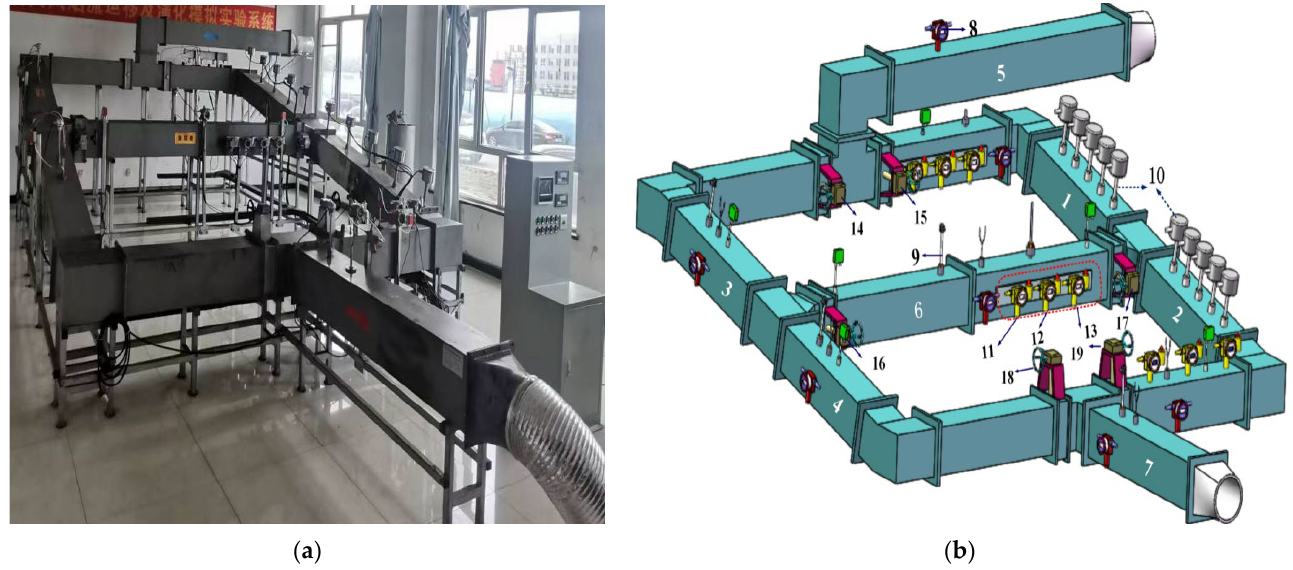
Figure 1. Experimental equipment: ( a ) Physical setup. ( b ) Schematic diagram. Note: 1. branch 1; 2. branch 2; 3. branch 3; 4. branch 4; 5. intake airway; 6. diagonal branch; 7. return airway, 8.